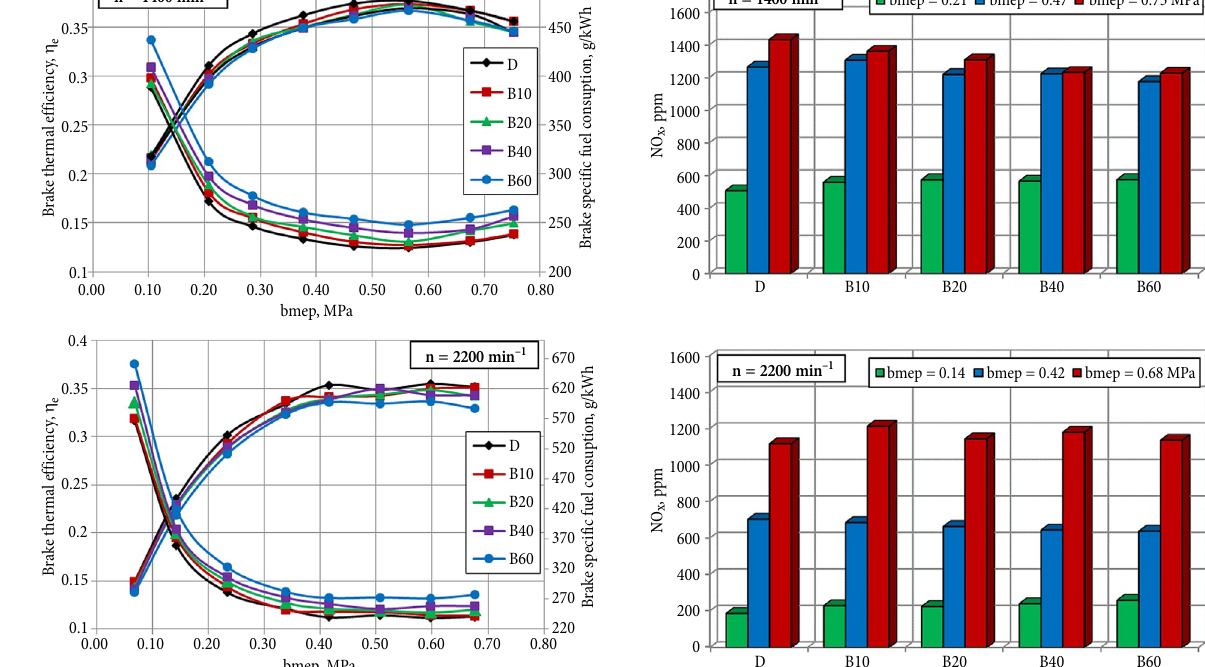
Fig. 7. Dependence of the bsfc and brake thermal efficiency on engine load ( bmep )